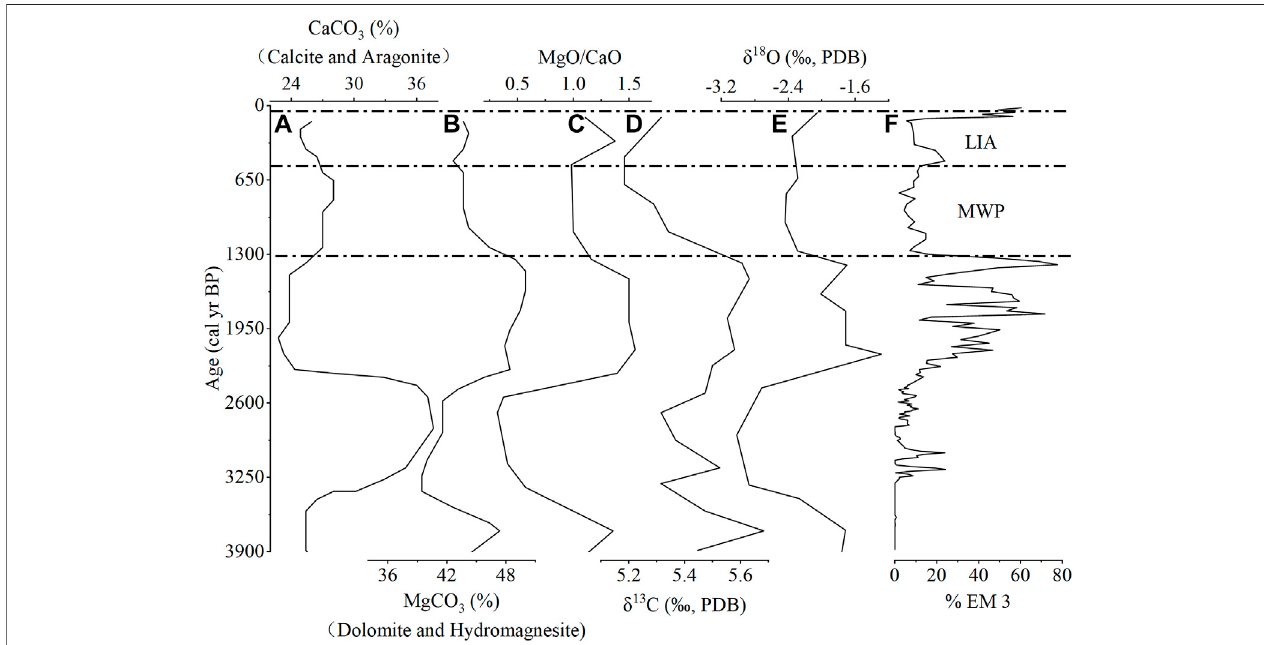
FIGURE 8 | (A) , (B) , (C) , (D) , (E) CaCO 3 , MgCO 3 , MgO/CaO, δ 13 C, and δ 18 O records in the core CH8803 of Lake Selin Co, respectively (Gu et al., 1993). (F) EM3 fraction (this